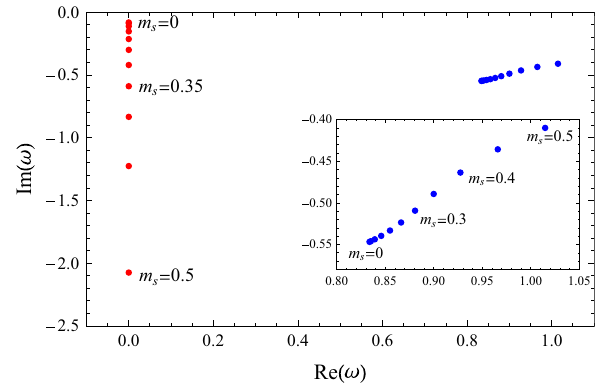
Fig. 5 The plot of real and imaginary part of quasinormal frequencies for M = 1 ,α g = 1 ,(cid:14) = 0 ,α 2 m = − 0 . 16 ,γ = 1 . 5 ,λ = 1 , k = 0 for varying m s . A subplot is displayed to clarify the effect of m s on the non-zero-real-part modes